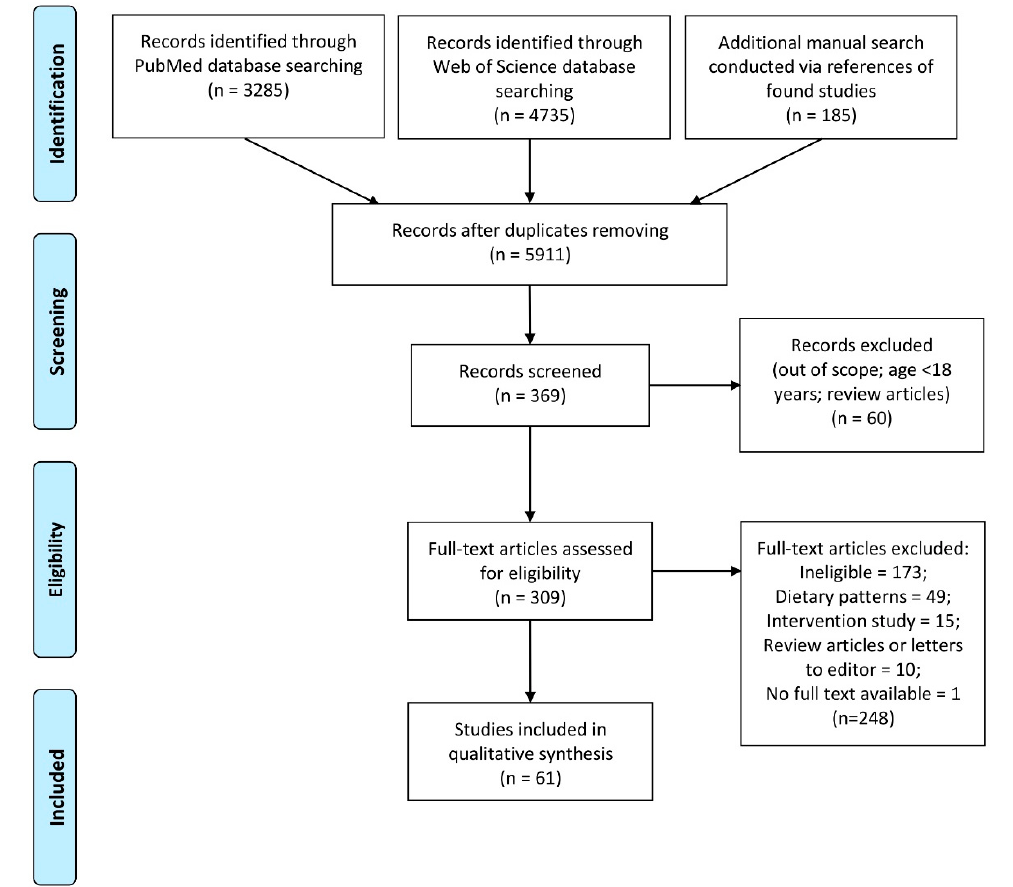
Figure 1. Procedure of identification, screening, eligibility assessment, and inclusion within the conducted systematic review.